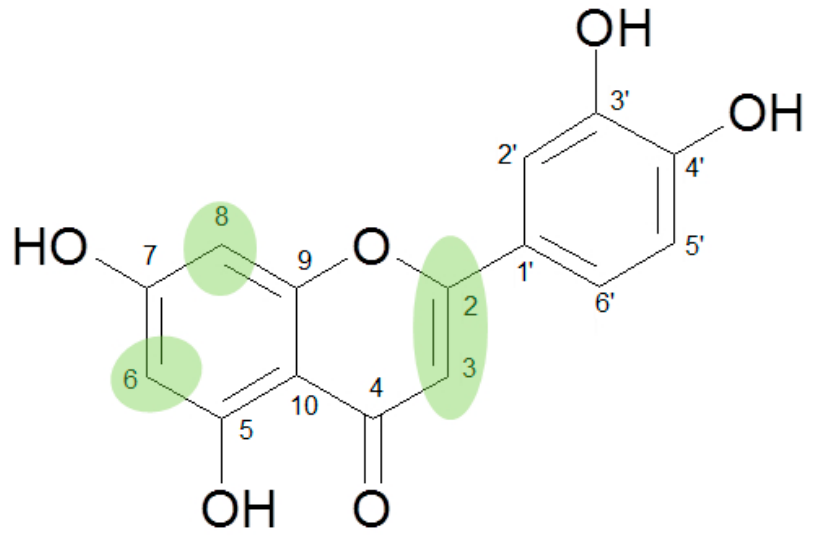
Figure 1. Structural features of flavonoids indispensable for high activity in the CCID